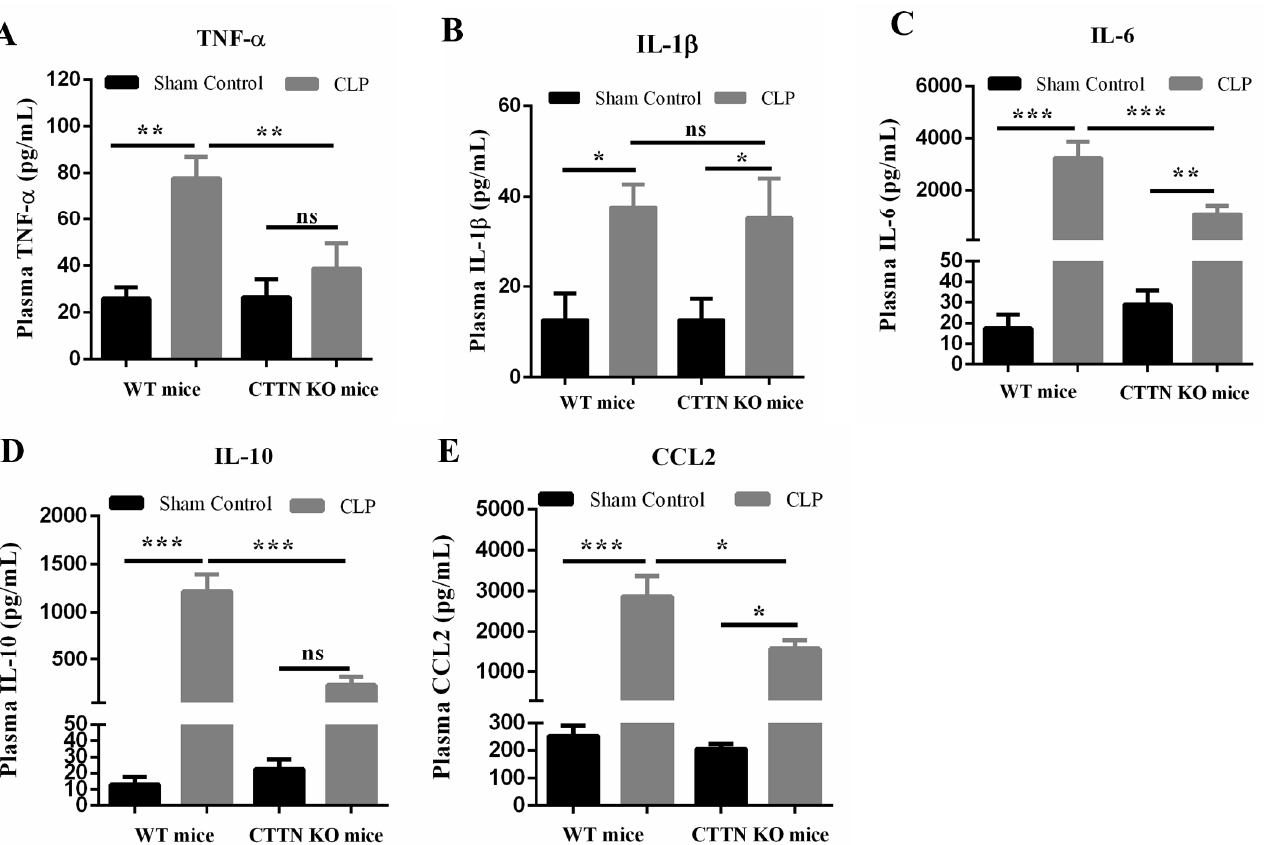
Figure 3. Loss of cortactin ameliorates systemic inflammation during sepsis. Plasma protein levels of the cytokines ( A ) TNF- α , ( B ) IL-1 β , ( C ) IL-6, ( D ) IL-10, and ( E ) CCL2 were measured 24 h after CLP sepsis or sham control. Data are represented as mean ± SEM of at least 6 animals per group. * p < 0.05, ** p < 0.01, *** p < 0.001. ns: non-significant.